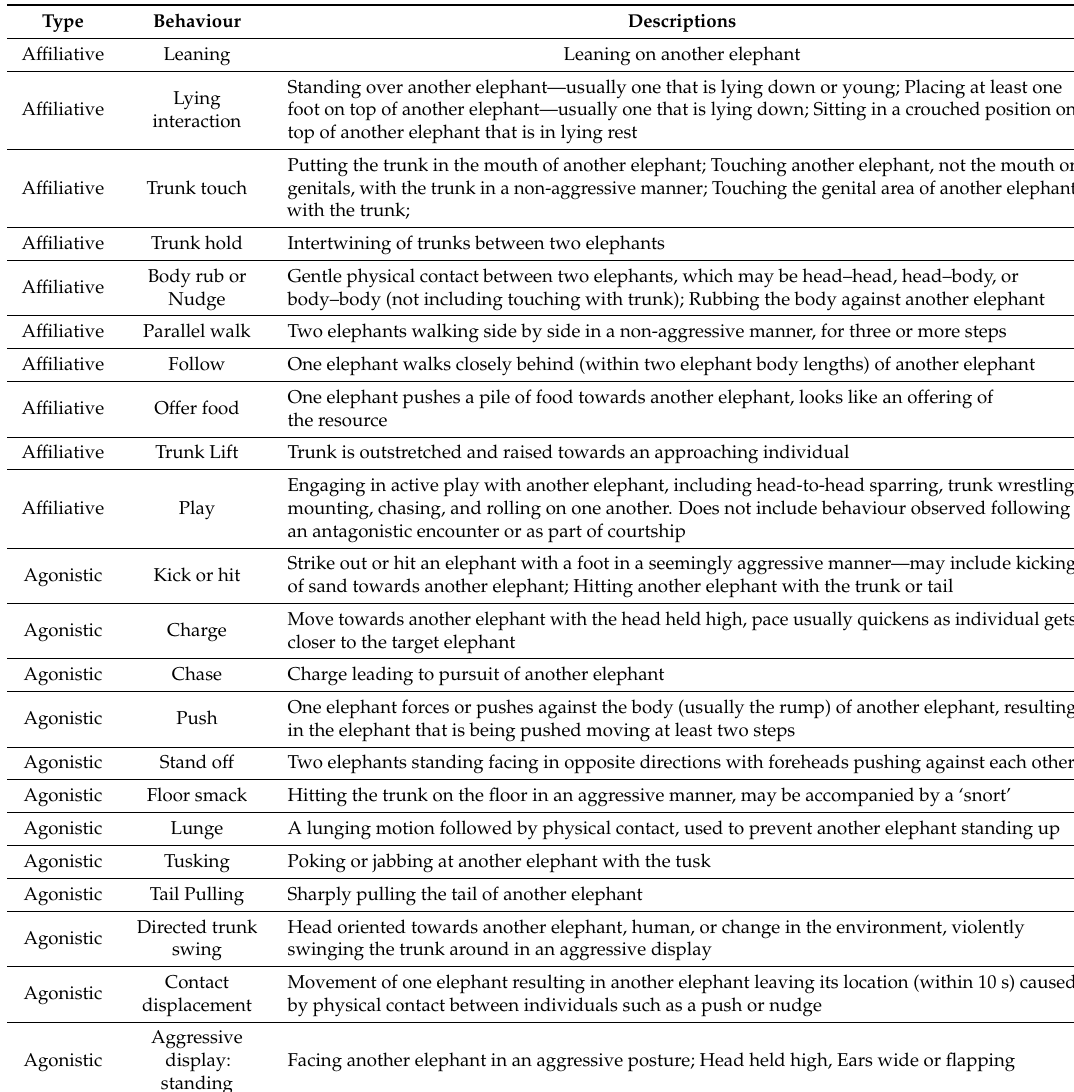
Table 2. Descriptions of social interactions used in the ethogram for data